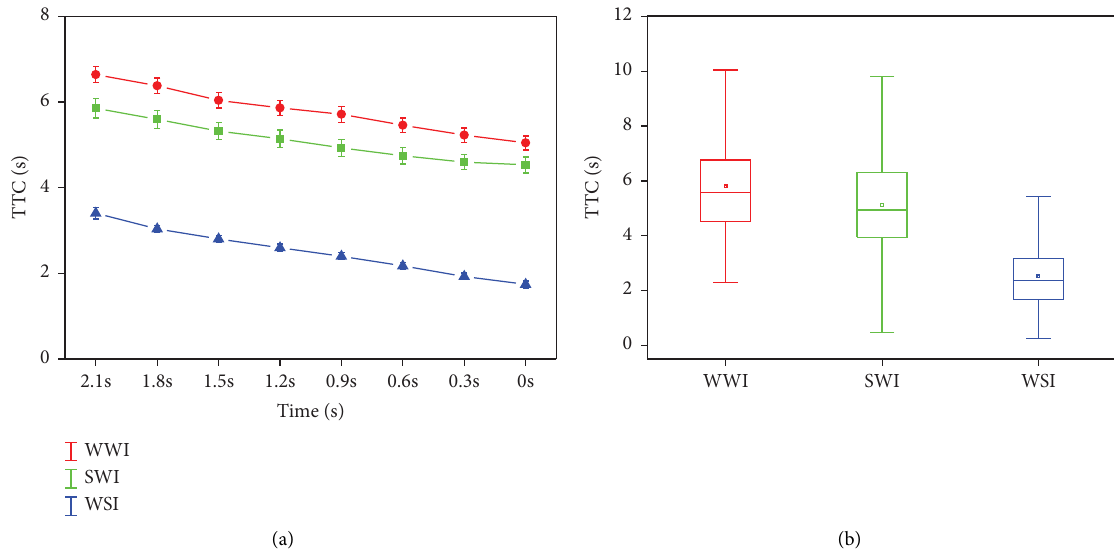
Figure 8: TTC under diferent crossing intentions. (a) Line chart of TTC change with time under diferent intentions. (b) Box diagram of TTC under diferent crossing intentions.